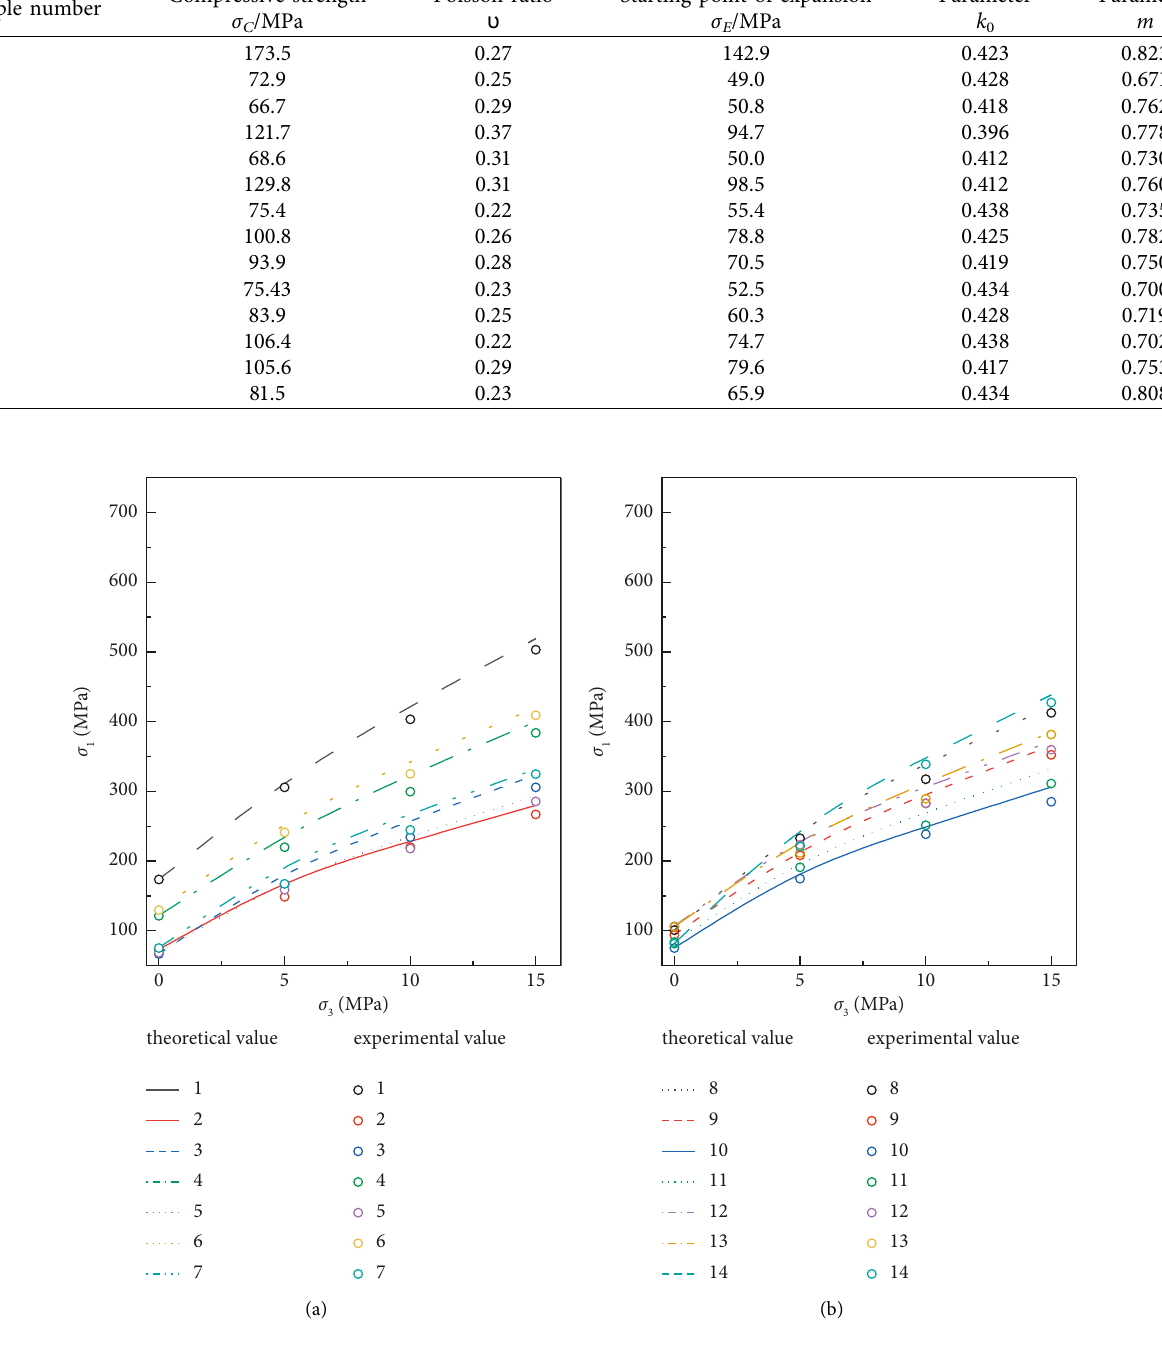
Figure 5: Comparison of theoretical and actual strength of